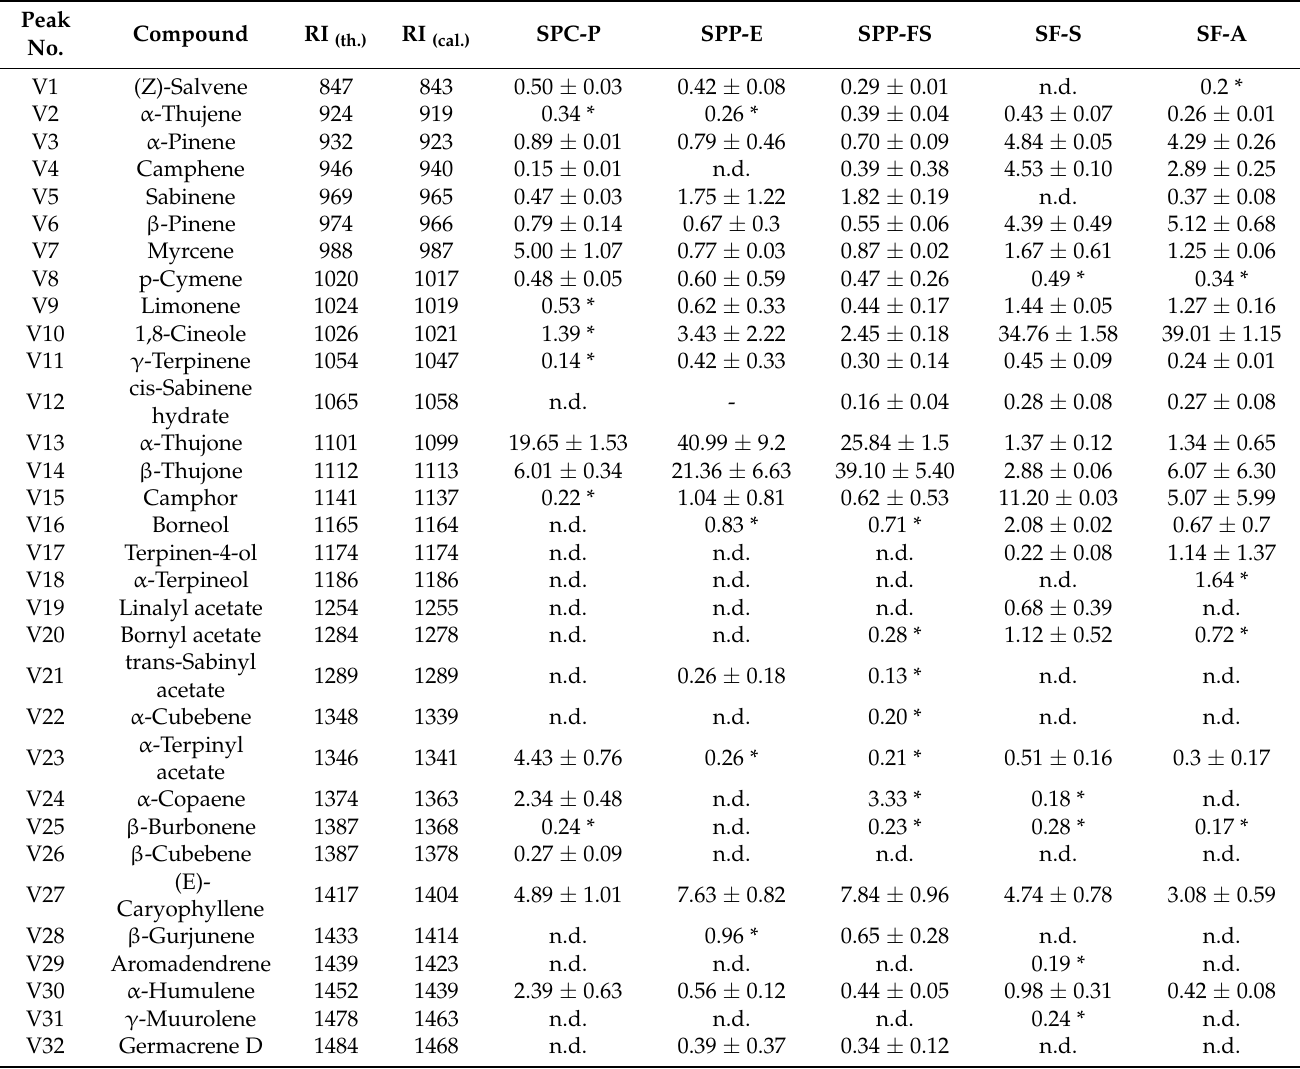
Table 1. The major volatile compounds in petroleum ether extracts of the leaves of the five Salvia populations using GC/MS. The results are expressed as a percentage of the total peak area (means ± standard deviation), while the limit for identification and quantification was set at 0.10%.